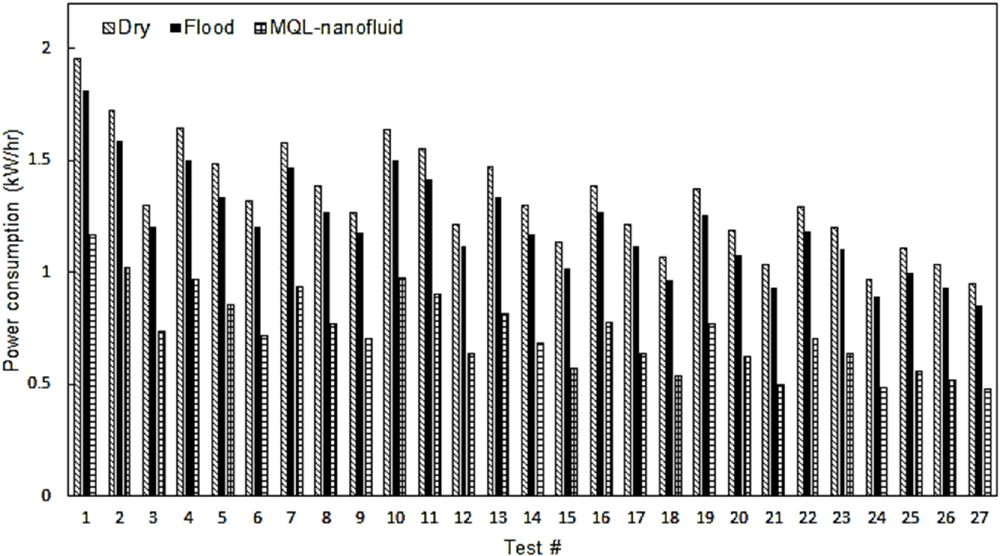
Figure 6. The power consumption results.